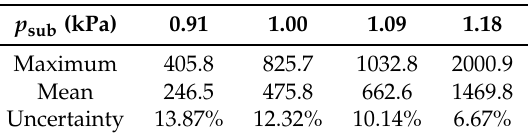
Table 7. Estimated average maximum and mean contact pressures along with a measure of uncertainty in the form of a standard deviation as a percentage of the mean estimated value for the cases with medial compression. All data are in